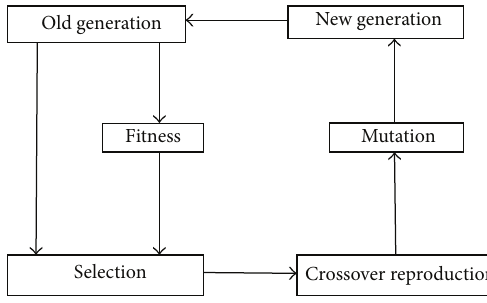
Figure 3: Block diagram of GA.